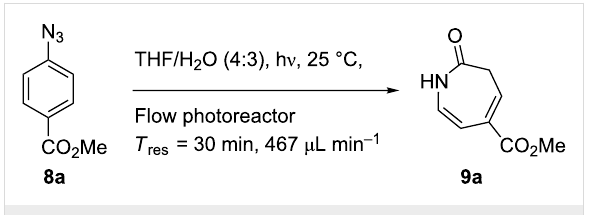
Scheme 2: Optimisation of the photolysis of aryl azide 8a